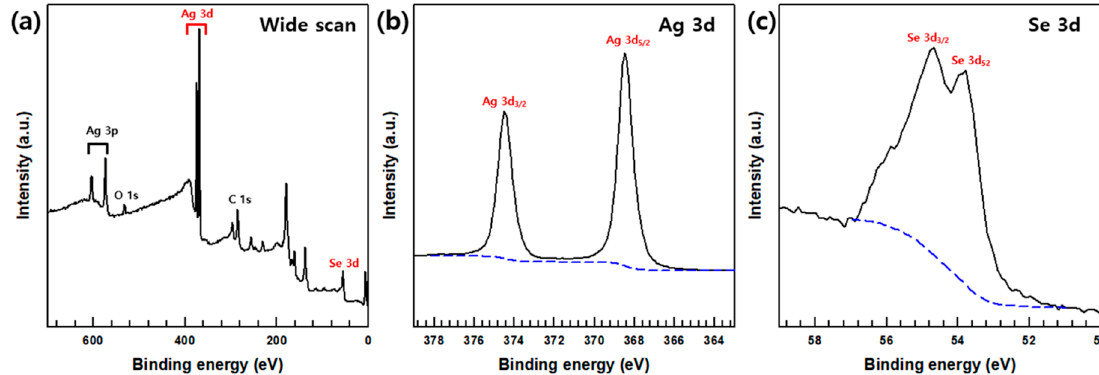
Figure 2. ( a ) XPS survey spectrum of Ag 2 Se NWs, high-resolution XPS spectra of ( b ) Ag 3d, and ( c ) Se 3d core level.